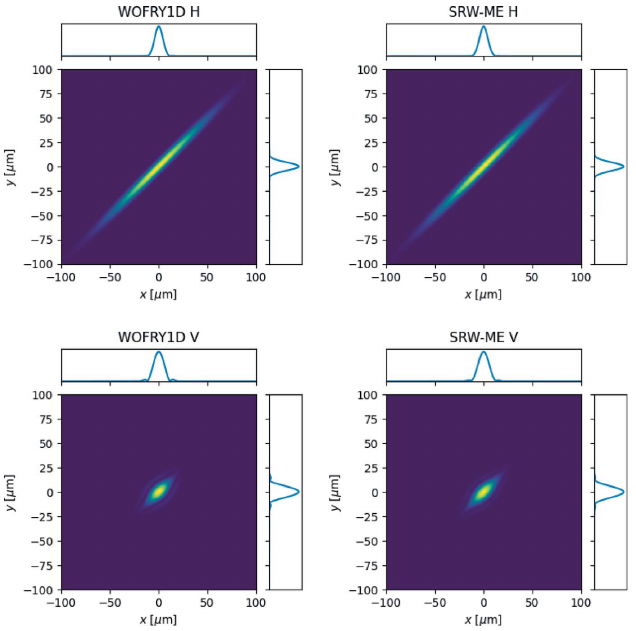
Figure 4 Cross-spectral density at the source plane ( z = 0) calculated by WOFRY1D and SRW-ME for the horizontal (top row) and vertical (bottom row) directions. The profiles correspond to the lines passing through (0, 0).